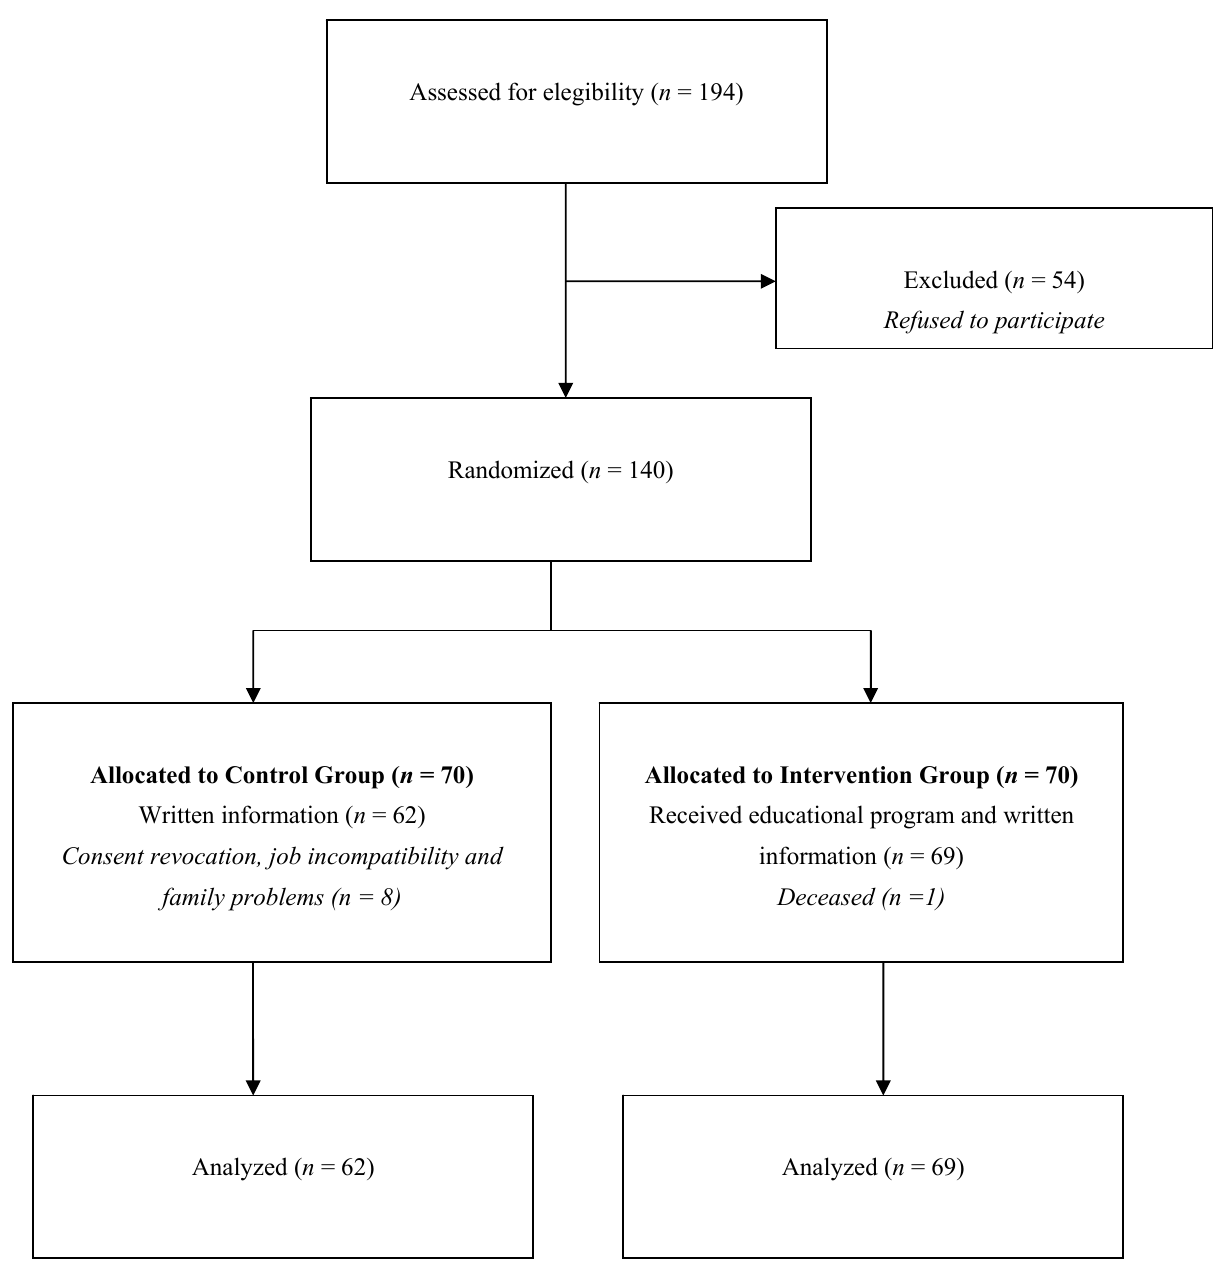
Figure 1. The sample flow chart and the number of participants.